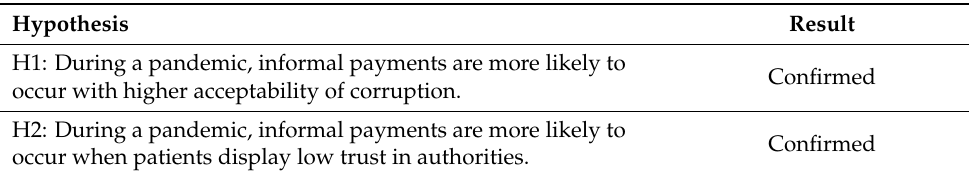
Table 6. Summary of the